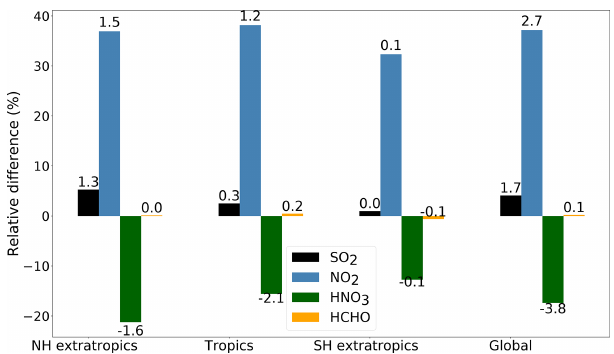
Figure 9. Relative change [%] and absolute change [Tgyr − 1 ] (num- bers on bars) of annual global loss by dry deposition of O 3 , SO 2 , HNO 3 and HCHO (REV –